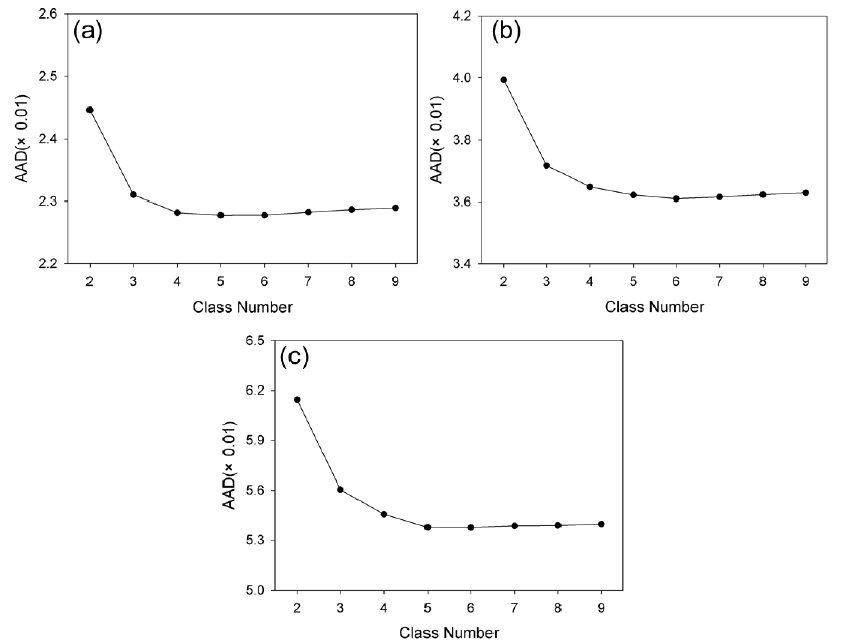
Figure 14. The prediction error (AAD) vs . class number for three study sites, ( a ) the forest site (prediction date: 11 July 2001); ( b ) Coleambally site (prediction date: 12 February 2002); and ( c ) Gwydir site (prediction date: 2 May